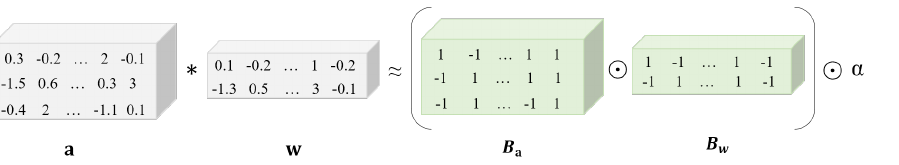
Figure 1. The quantization process from full-precision convolutional neural network to binary convolutional neural network.